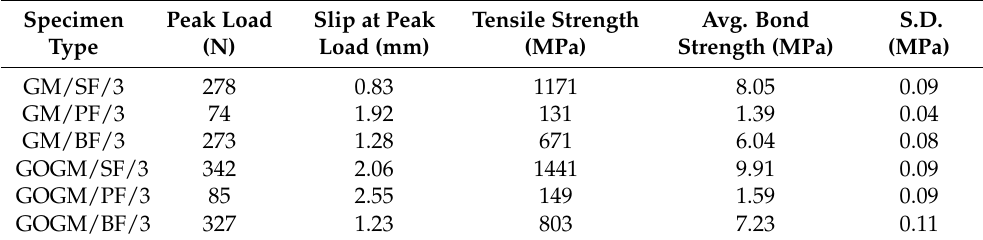
Table 8. Peak load and strength of fiber subjected 3 mm/s loading